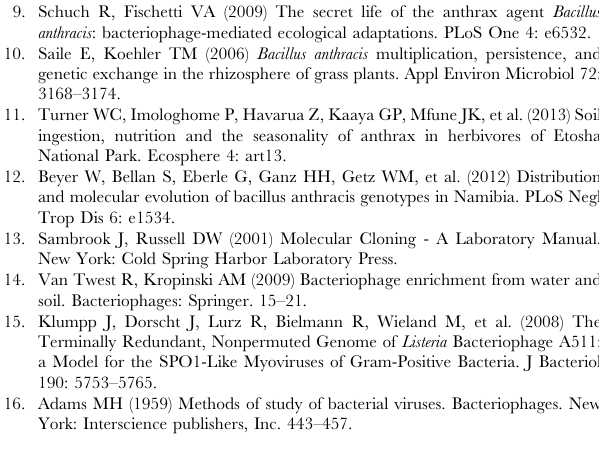
Table S1 Database matches of predicted proteins encoded by Bacillus anthracis phage